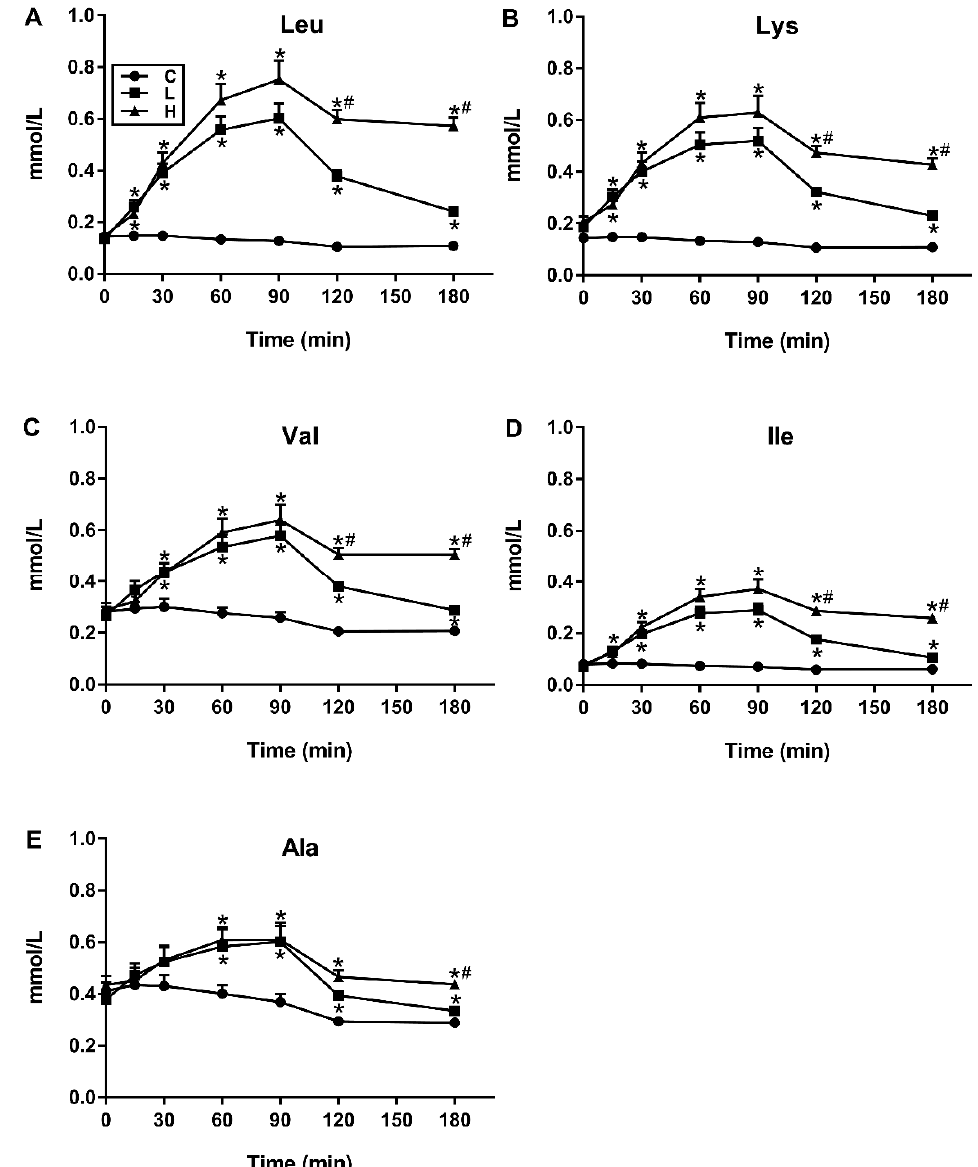
Figure 1. Temporal profiles of ( A ) Leucine (Leu), ( B ) Lysine (Lys), ( C ) Valine (Val), ( D ) Isoleucine (Ile) and ( E ) Alanine (Ala), the five amino acids whose plasma concentrations increased the most in response to test drinks containing either 0 g (C), 30 g (L) or 70 g (H) of pure whey protein dissolved in varying amounts of distilled water, diet cordial, and sodium chloride so they were matched for volume and osmolarity (all 450 mL and 88 mOsm / L). These responses were defined as being the strongest based on the “magnitude of increase” in each plasma concentration over the 180-min period following the L and H drink, respectively, and relative to C. Data are means ± SEMs, n = 16. E ff ects of protein load and time on individual AAs were determined by a two-way ANOVA, and post-hoc comparisons between two loads were determined using Bonferroni’s correction; statistical significance was accepted at p < 0.05. * Significantly di ff erent from C; # Significantly di ff erent from L ( p <